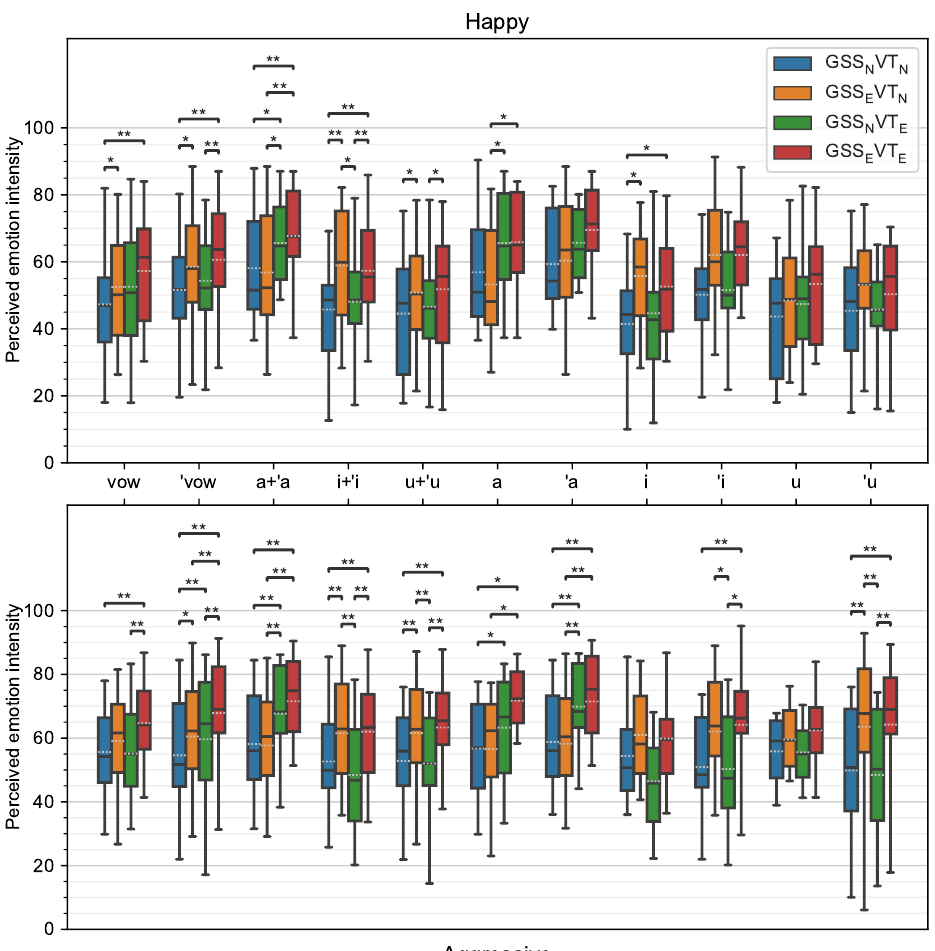
Figure 5. Results of the MUSHRA perceptual test. Boxplots depict the perceived emotion intensity scores reported by the participants. The dotted lines represent the mean of the distributions, and whiskers are set to 5th and 95th percentiles. The statistically significant differences are marked with ** ( p < 0.01) and * ( p <